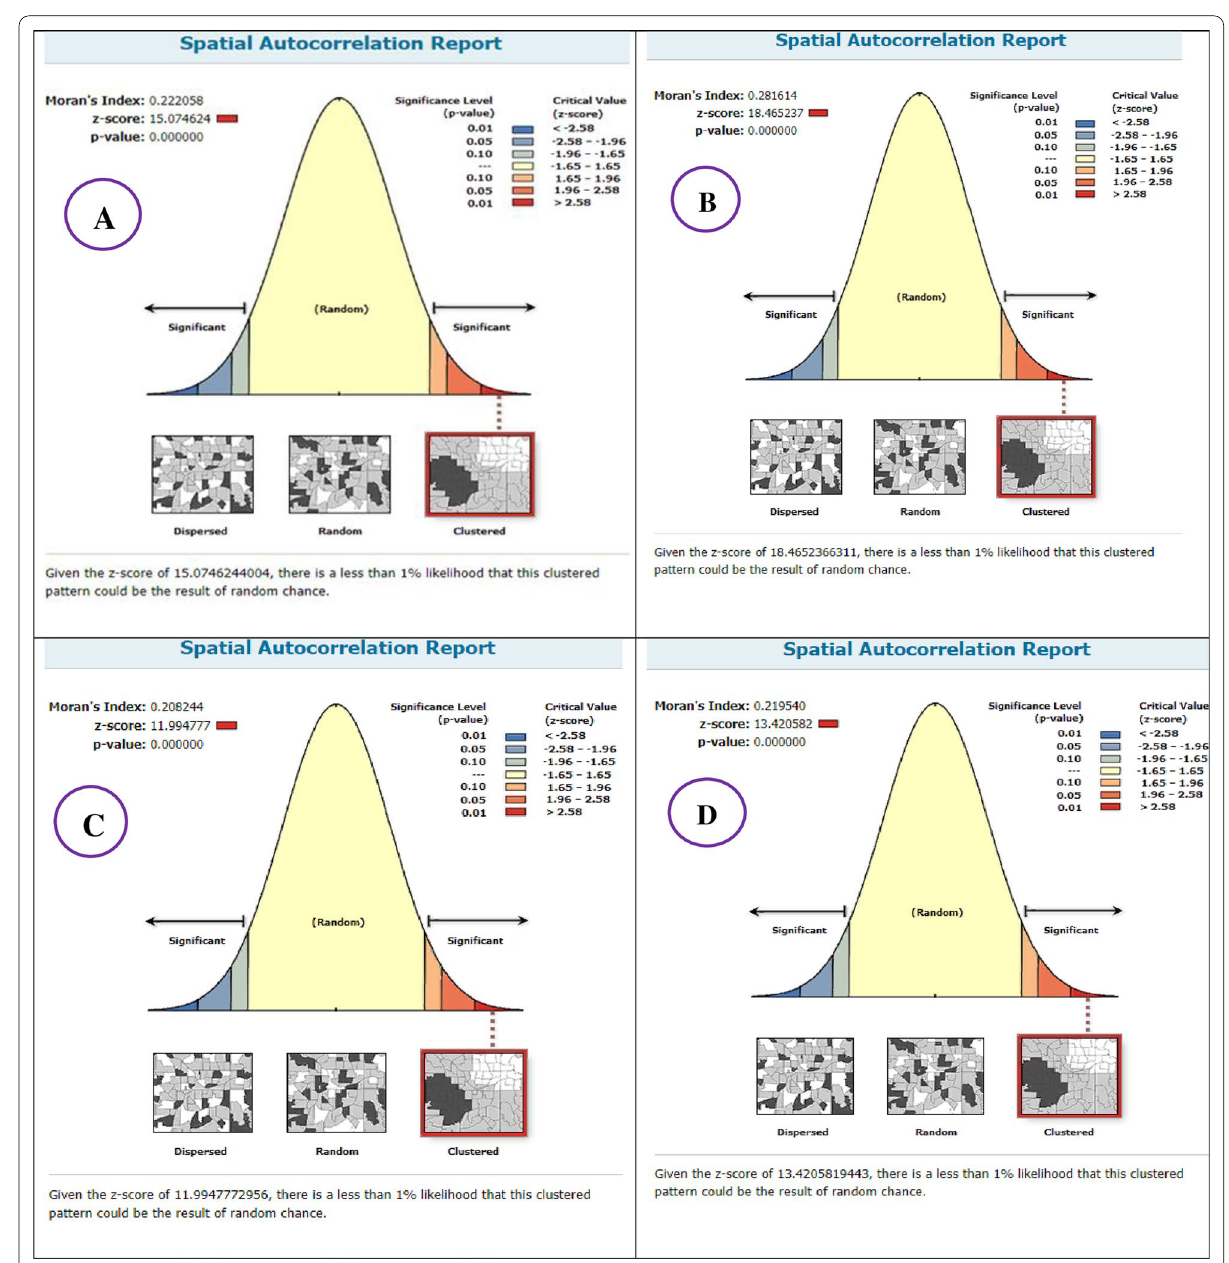
Fig. 3 Spatial autocorrelation analysis of unintended pregnancy among reproductive-age women in Ethiopia, EDHS 2000 ( A ), 2005 ( B ), 2011 ( C ), and 2016 ( D